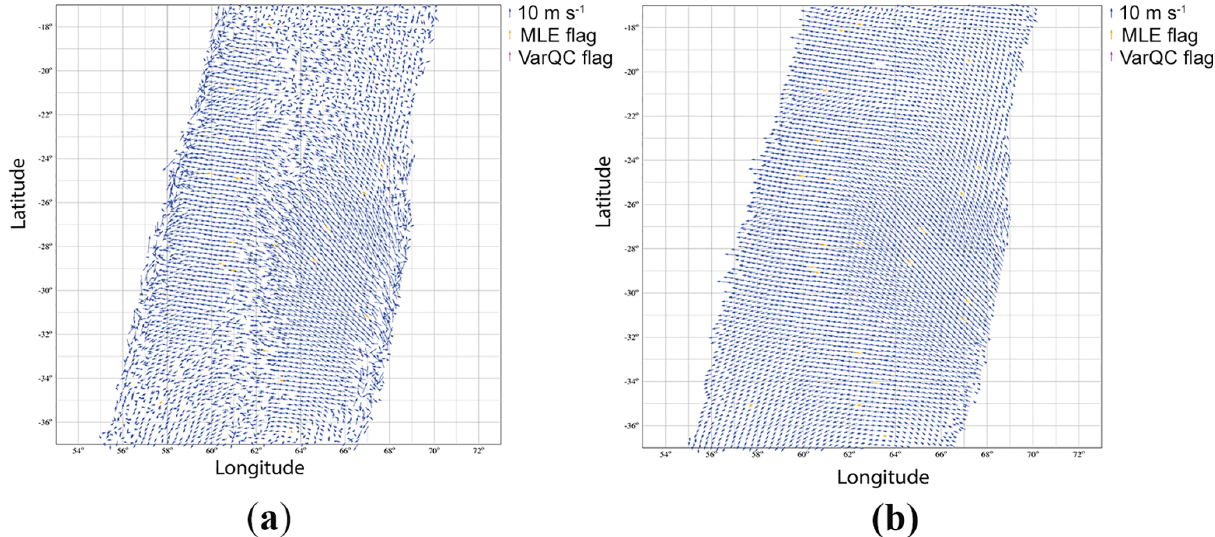
Figure 14. SCAT-retrieved wind field. (a) First rank solution. (b) 2DVAR result. The orange flags are artificial quality control points and may be